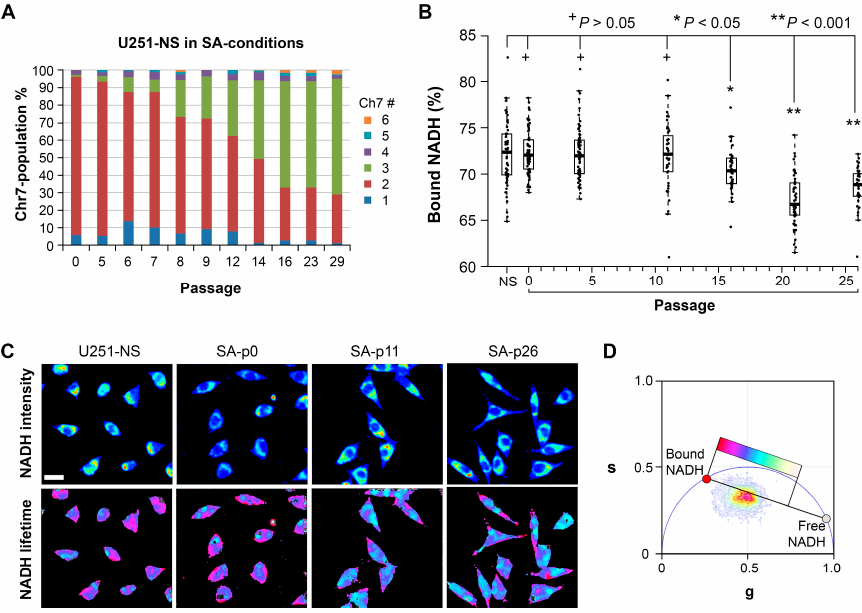
Figure 3. FLIM analysis of in vitro cultures experiencing a dynamic change in equilibrium between cell subpopulations. ( A ) Changes in population equilibrium in U251-NS following culturing in SA-conditions. Cells carrying different numbers of Chr7 were determined by FISH as reported in Hu et al., 2013 [15]. Colors represent the number of copies of Chr7 per cell as defined by the legend. ( B ) Comparison of changes of bound-NADH fraction in U251-NS over passages in SA-conditions. FLIM was acquired on one-day culture from a seeding density of 1 × 10 5 /well in eight-well chamber slides. Boxplots represent the first quartile, median and third quartile. Each point on the plot represents a single cell. ( C ) Representative FLIM images of U251-NS before and after its culture in SA-conditions in various passages (p0, p11, and p26). NADH intensity is represented with warmer colors indicating higher intensity (top), and the fluorescence lifetime of NADH (bottom) is represented with colors indicated by the location of each pixel on the phasor plot ( D ). A higher fraction of bound NADH is represented as red, and free NADH is represented as white. The scale bar represents 25 μ m.